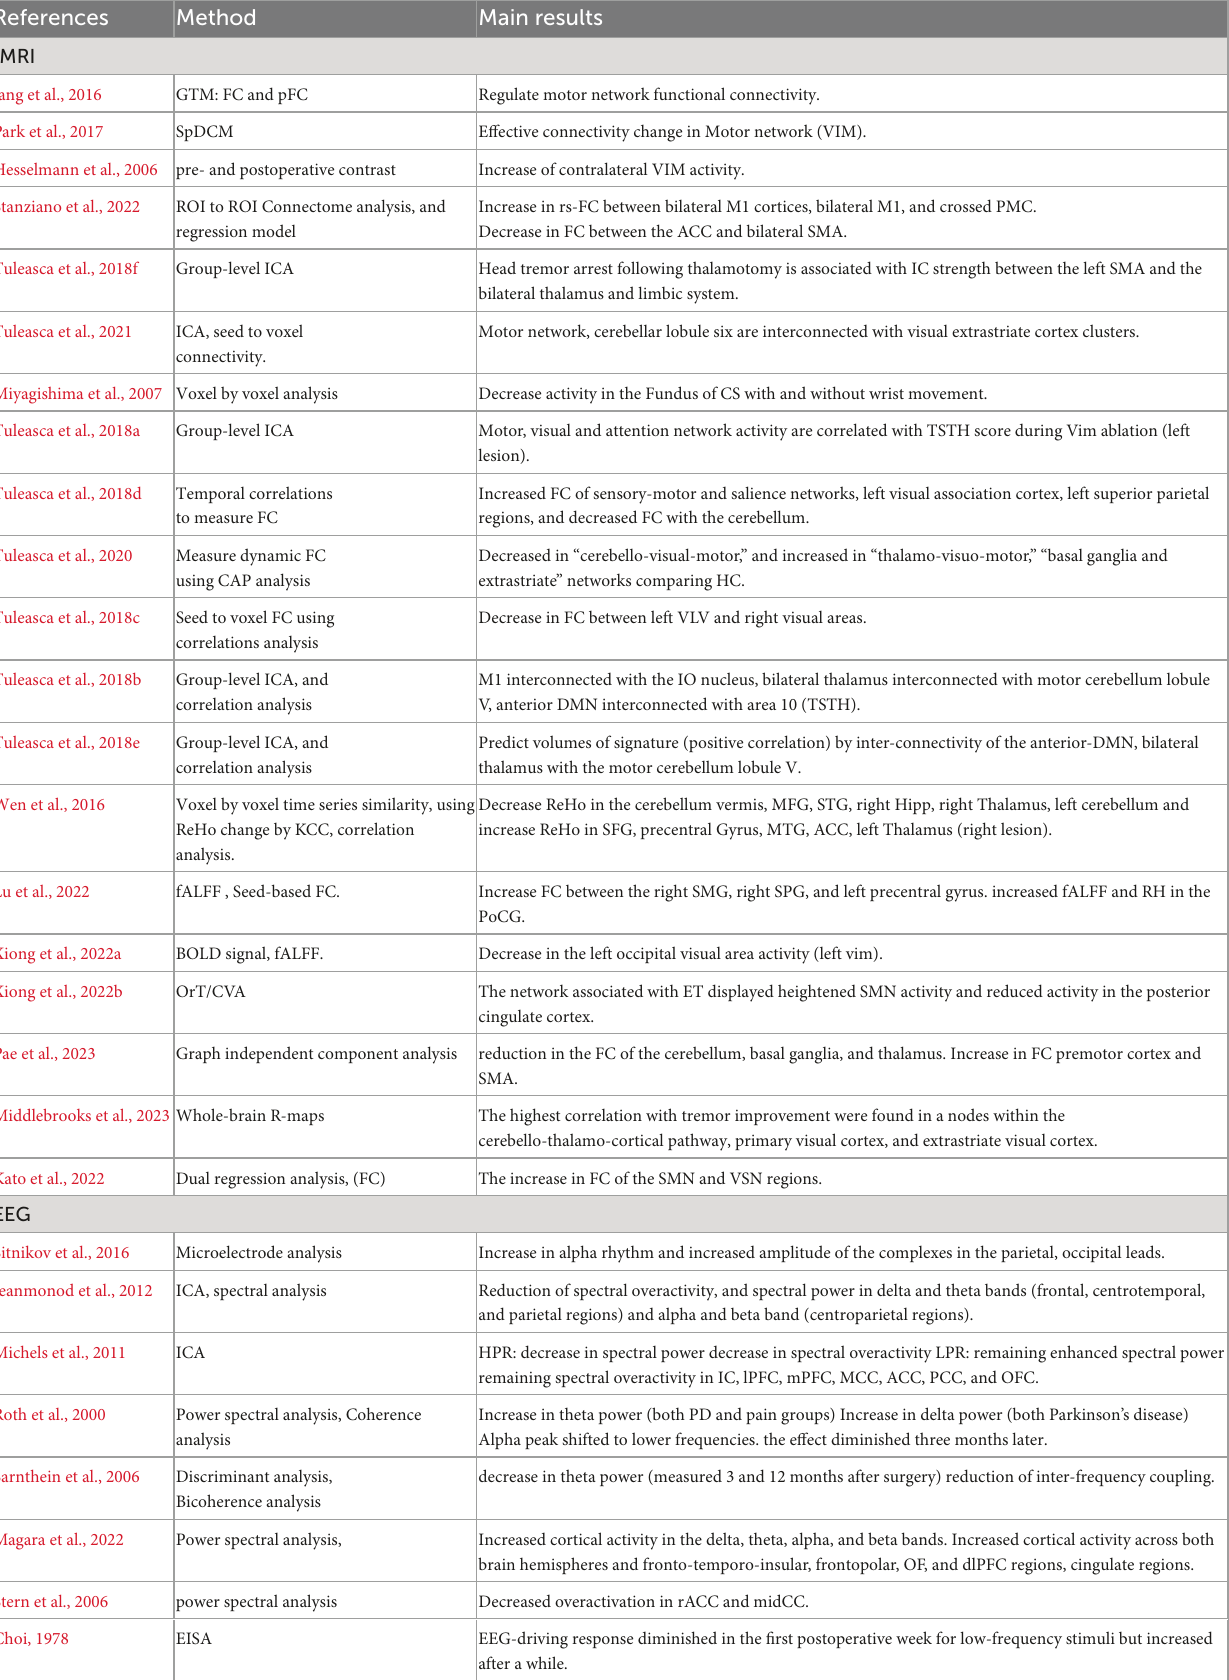
TABLE 1 This table summarized functional connectivity studies during thalamotomy